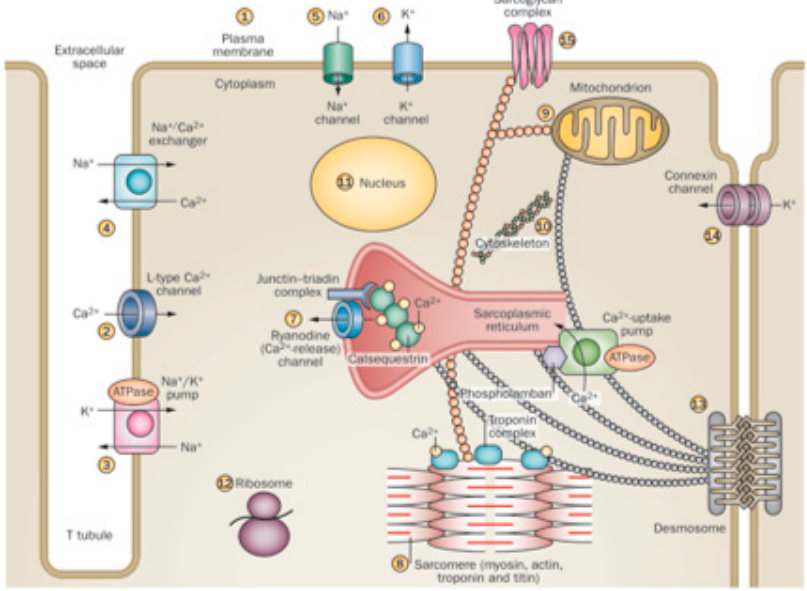
Figure 1. Different effects of ethanol on cardiomyocyte organelles. (Adapted form Nature 451; 929–936, 2008). Cardiac myocytes are excitable cells with complex signaling and contractile structures and are highly sensitive to the toxic effect of alcohol on: (1) plasma membrane composition and permeability, signaling, and activation of apoptosis; (2) L-Type Ca 2+ channel activity; (3) Na + /K + ATPase channel activity; (4) Na + /Ca 2+ exchanger activity; (5) Na + channel currents; (6) K + channel currents; (7) ryanodine Ca 2+ release; (8) sarcomere Ca 2+ sensitivity, excitation–contraction coupling, myofibrillary structure, and protein expression; (9) several aspects of mitochondrial function, including respiratory complex activities; (10) cytoskeletal structure; (11) nuclear regulation of transcription; (12) ribosomal protein synthesis; (13) desmosomal contacts; (14) connexin channel communication; (15) sarcoglycan complex interactions. Table 1. Mechanisms of alcohol-induced heart damage and their effectors.